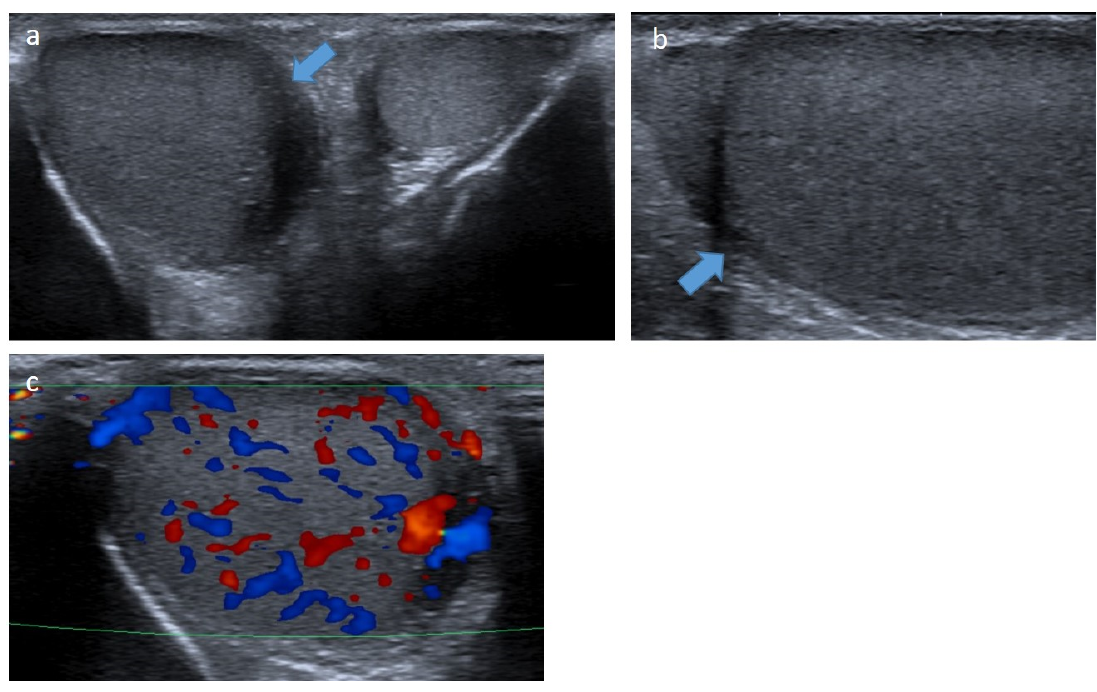
Figure 8. Leukemic testicular infiltration of the right testis in a 10-year-old boy. Transverse ( a ) and longitudinal ( b ) gray-scale B-mode and transverse color Doppler ( c ) US of the testis. Images show an enlargement of the right testis demonstrating an ill-defined hypoechoic infiltration (blue arrow) with increased intralesional flow preserving the normal vascular architecture. This infiltration regressed on chemotherapy. US, ultrasonography.